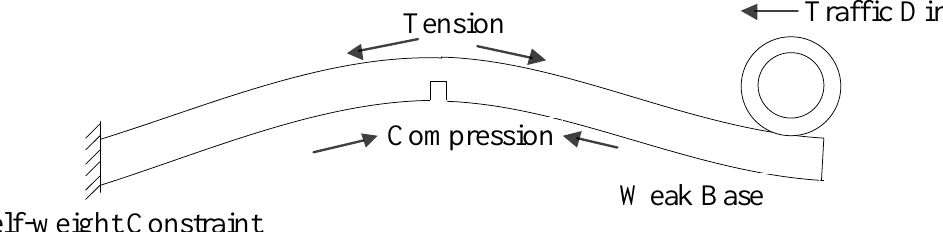
Figure 6. Mechanism sketch for SIRC .